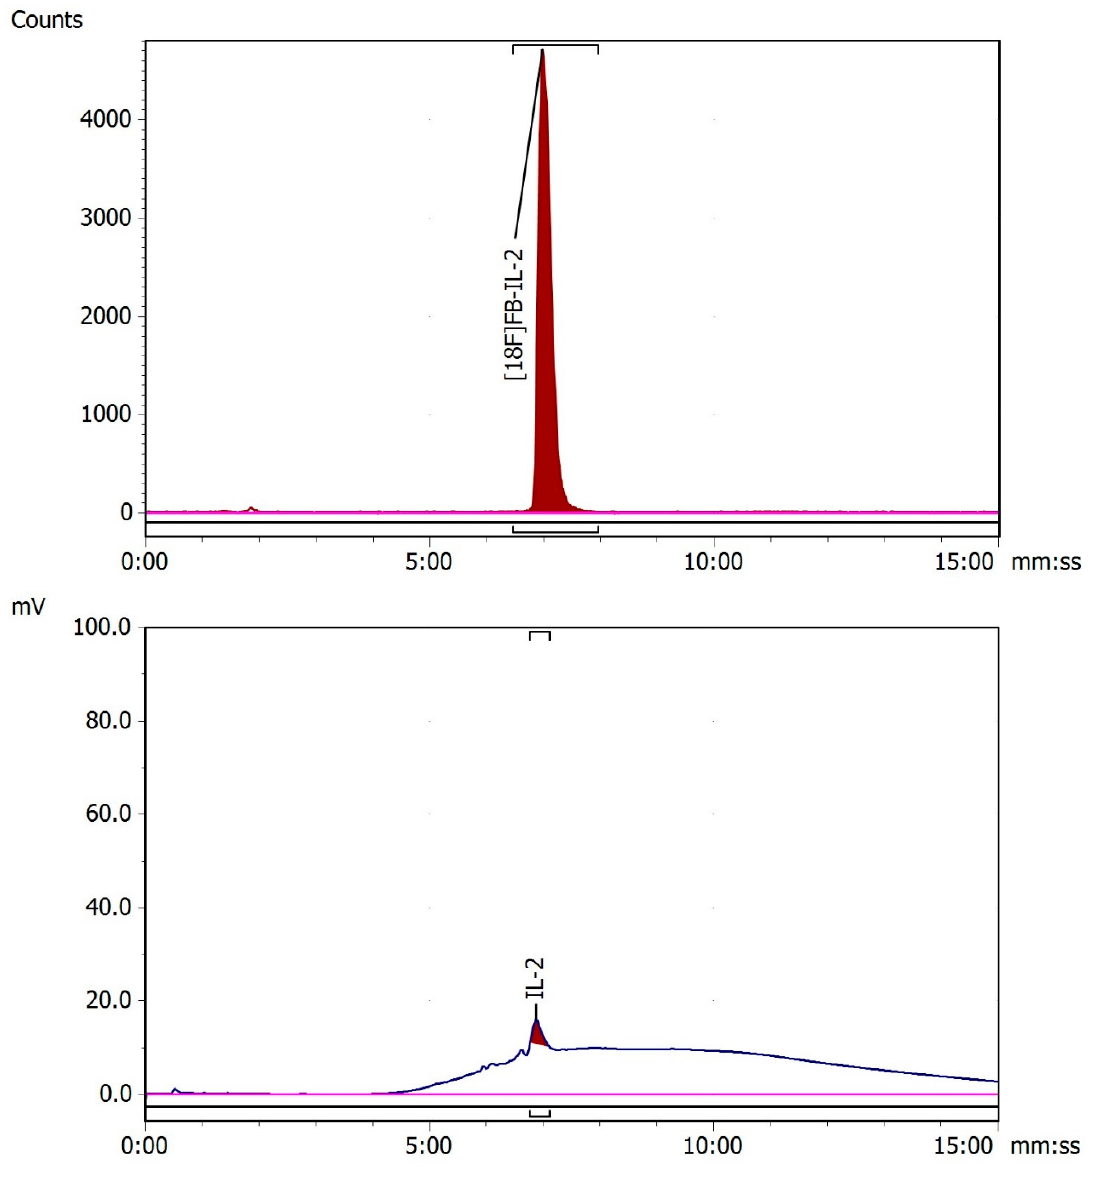
Figure 1. Radio- and UV chromatograms of the PD-10 purified formulated radiotracer, [ 18 F]FB-IL-2.